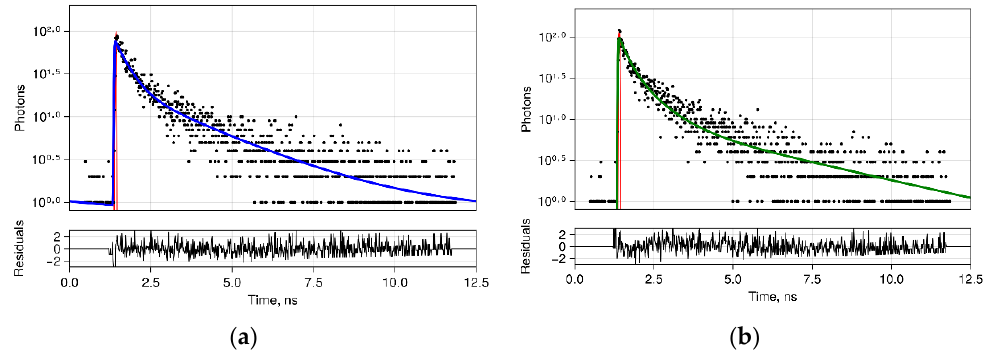
Figure 1. Fitting results for the lifetime of fluorescence in NADH (blue line, ( a )) and in FAD (green line, ( b )) spectral ranges. Red line is the IRF.